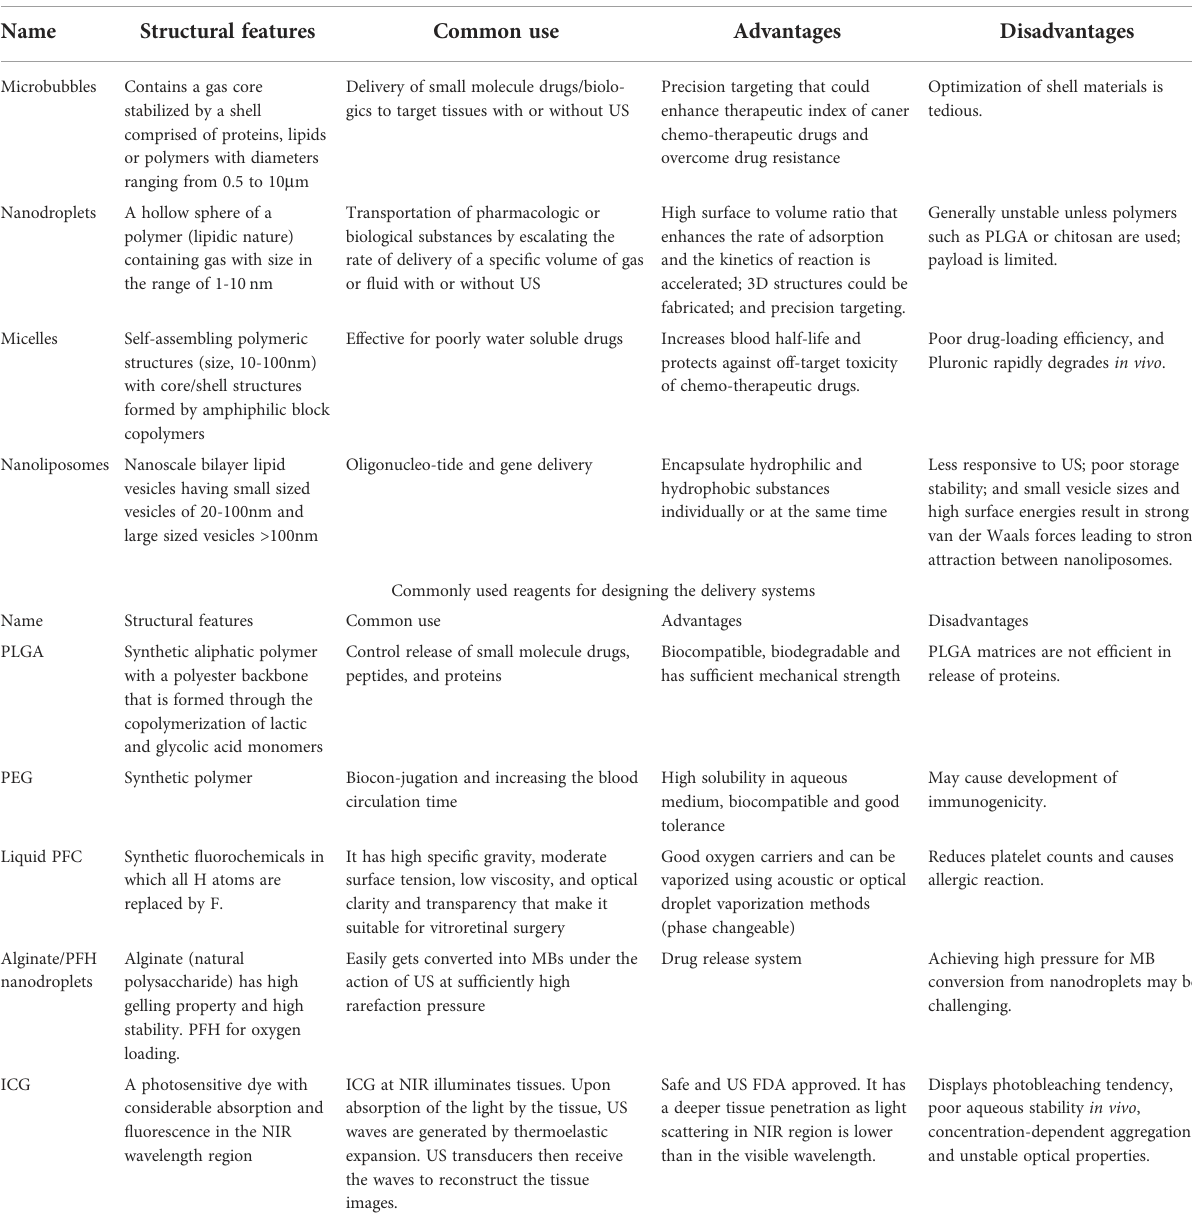
TABLE 1 Salient features of the delivery systems used for US-mediated targeting of ovarian tumors and reagents used for their